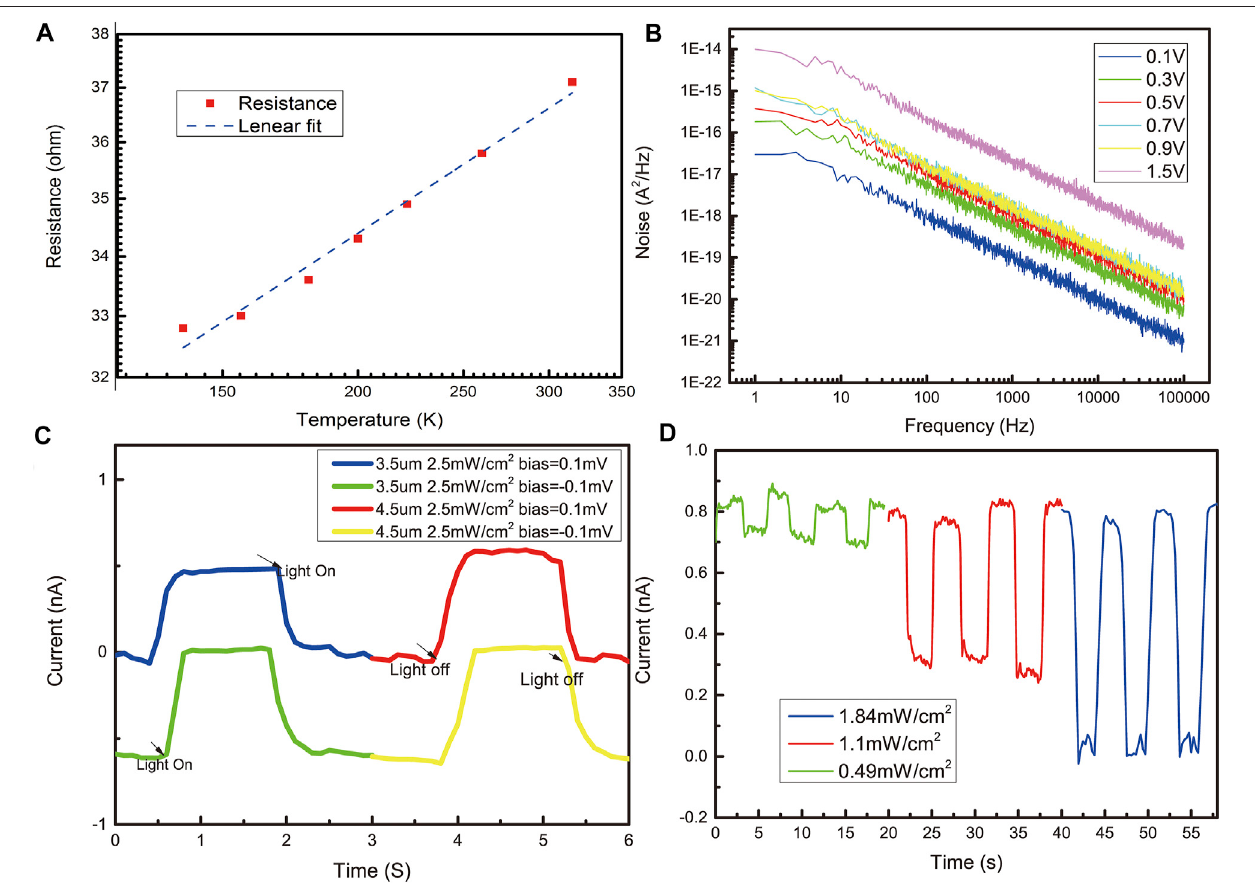
FIGURE4| Temperaturecharacter,noise,andmid-infraredresponseofBP. (A) Temperature-resistantrelationshipofsymmetricBP. (B) NoiseofatypicalbulkBP inmid-infraredradiationunderdifferentbiasvoltage. (C) NegativephotocurrentofBPundermid-infraredwavelengthof3.5and4.5 μ m. (D) NegativephotocurrentofBP for different radiation power for 4.5- μ m